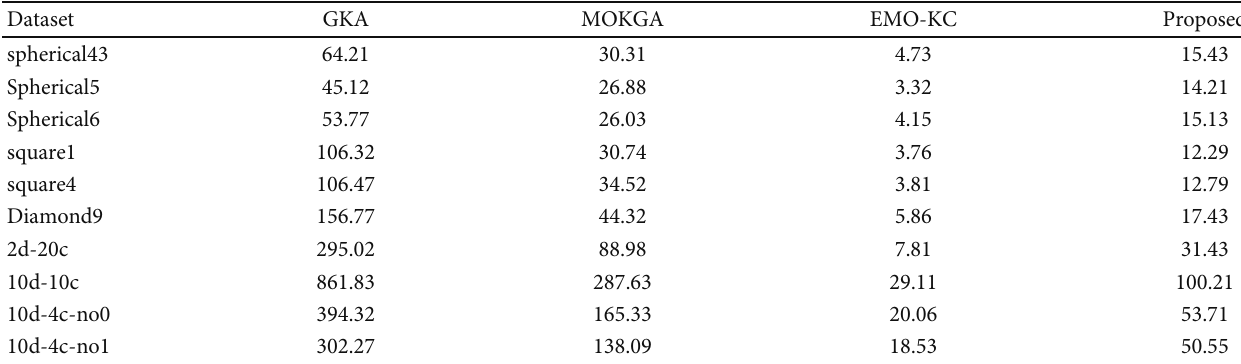
Table 2: Running time of each clustering algorithm on di ff erent datasets (s).